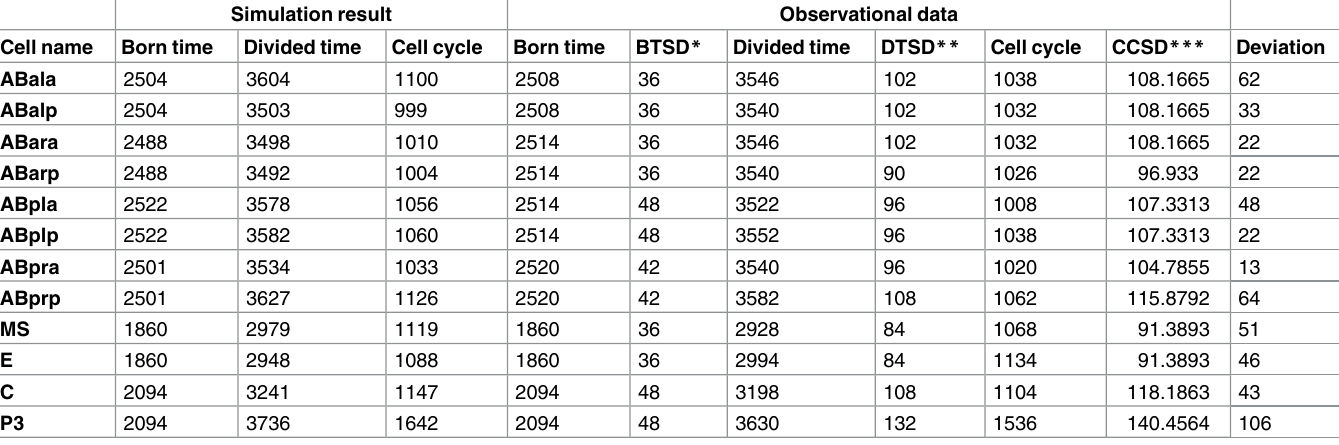
Table 6. Cell cycle analysis of 12 founder